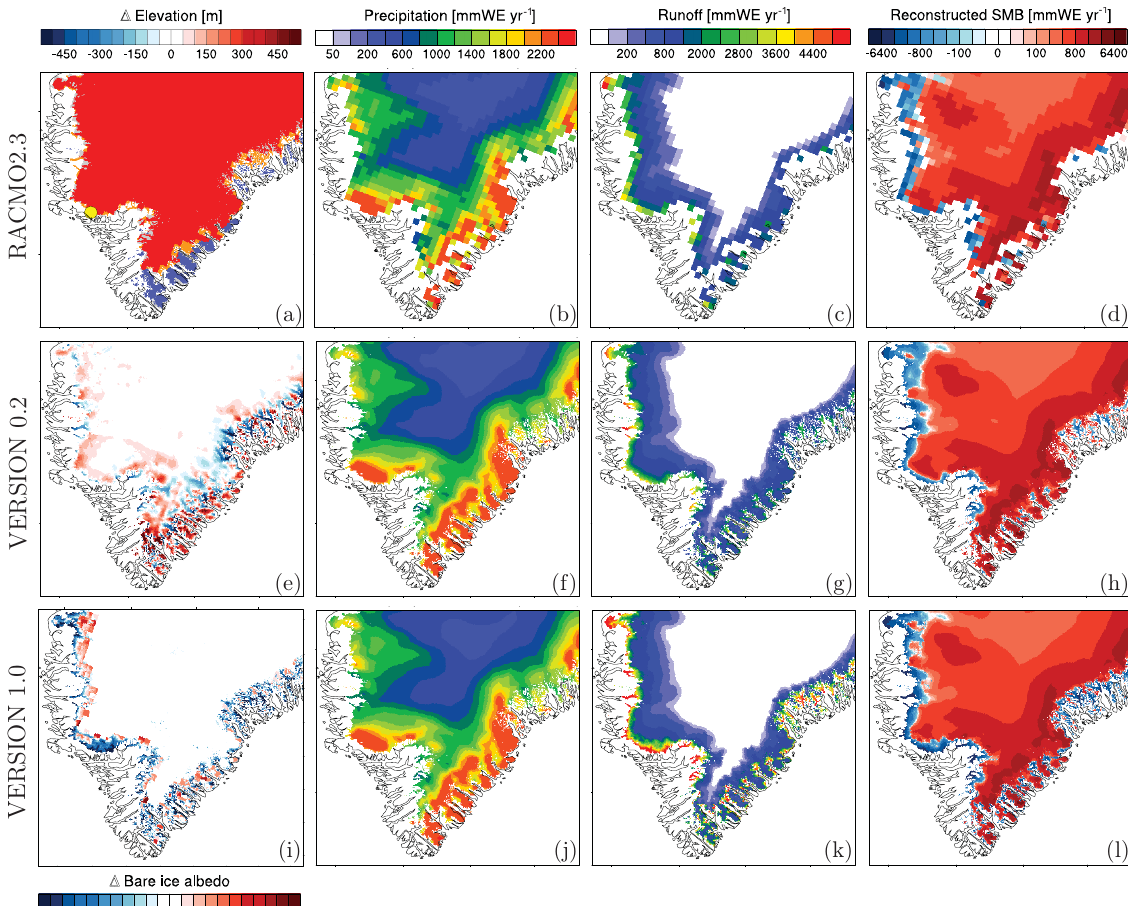
Figure 12. South: same as Fig. 10 but for south Greenland (blue box 3 in Fig. 1). The yellow dot in (a) locates station QAS_L.